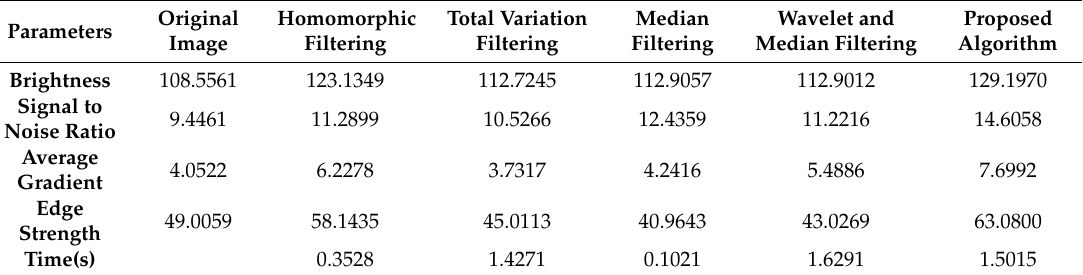
Table 4. Comparison of performance indicators of different algorithms.